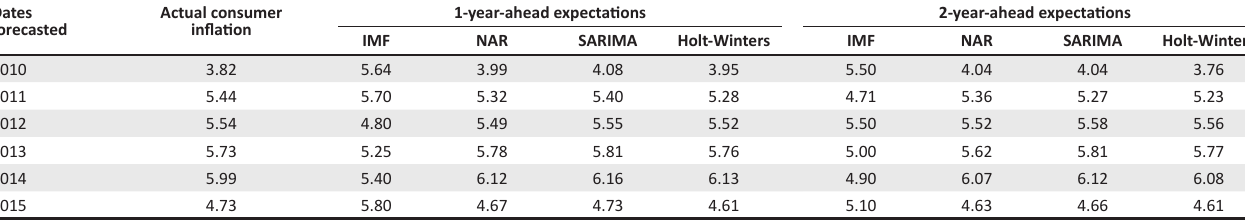
TABLE 1: Inflation expectation comparison with the International Monetary Fund – Yearly approach. Dates